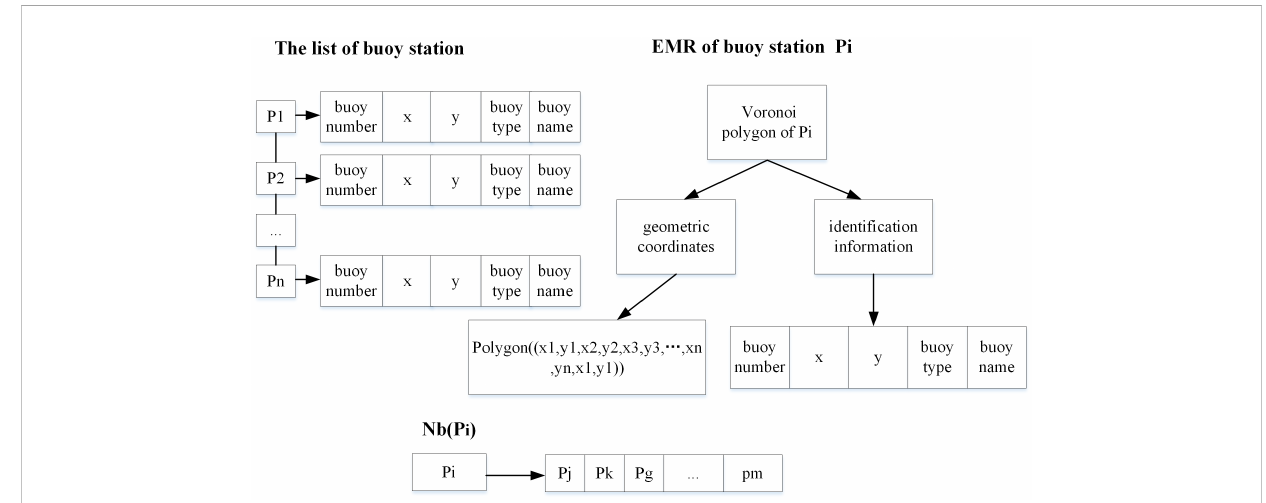
FIGURE 1 The Spatial Neighborhood Model (SNM) of ocean buoy